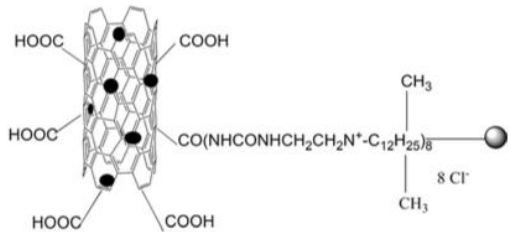
Figure 10. MWCNTs-PPI-AgNP hybrid. Reproduced with permission from reference [143]. Copyright 2011 Elsevier.